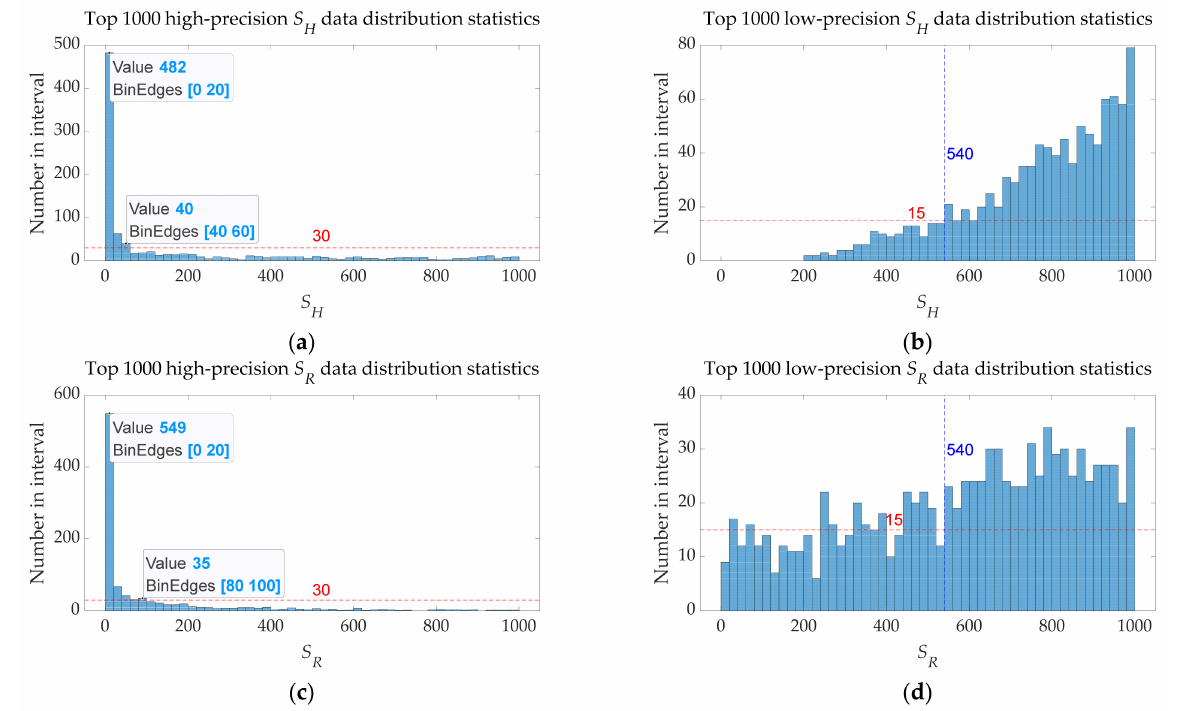
Figure 10. Speed control constant—OMO algorithm’s accuracy distribution histogram. ( a ) S H distribution histogram of the first 1000 sets of high-precision data; ( b ) S H distribution histogram of the first 1000 sets of low-precision data; ( c ) S R distribution histogram of the first 1000 sets of high-precision data; ( d ) S R distribution histogram of the first 1000 sets of low-precision